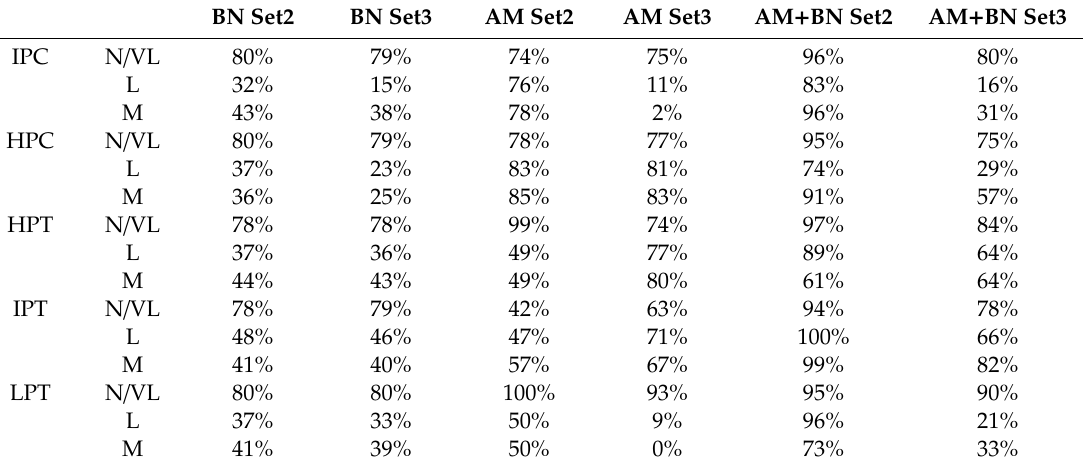
Table 11. Identified faults with di ff erent sensors sets and flight